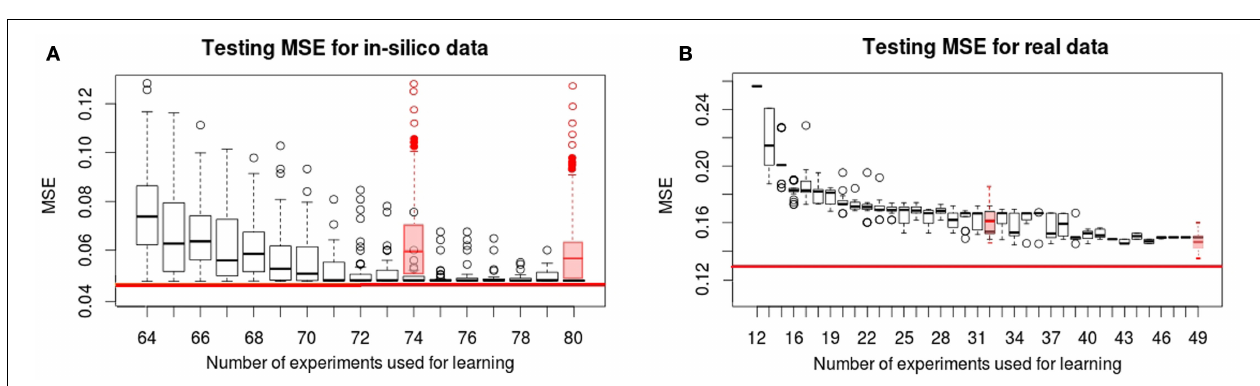
FIGURE 3 | Testing MSE for in silico (A) and real (B) phosphoproteomic datasets . The red line represents the optimal MSE learned using the full available experimental datasets (2 14 experiments for in silico and 120 for real datasets). The X -axis shows the number of experiments (optimal signaling perturbations and measurements associated) used for learning at each iteration.